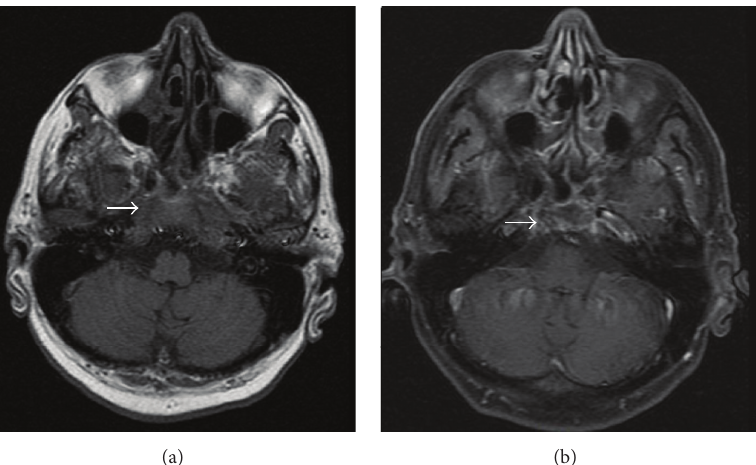
Figure 2: Initial axial enhanced T1-weighted MRI (a) show enhancement (arrow) of the clivus and occipital condyles corresponding to infiltration. Eight months later after systemic therapy axial enhanced T1-weighted MRI (b) shows significant reduction of the enhancement (arrow).